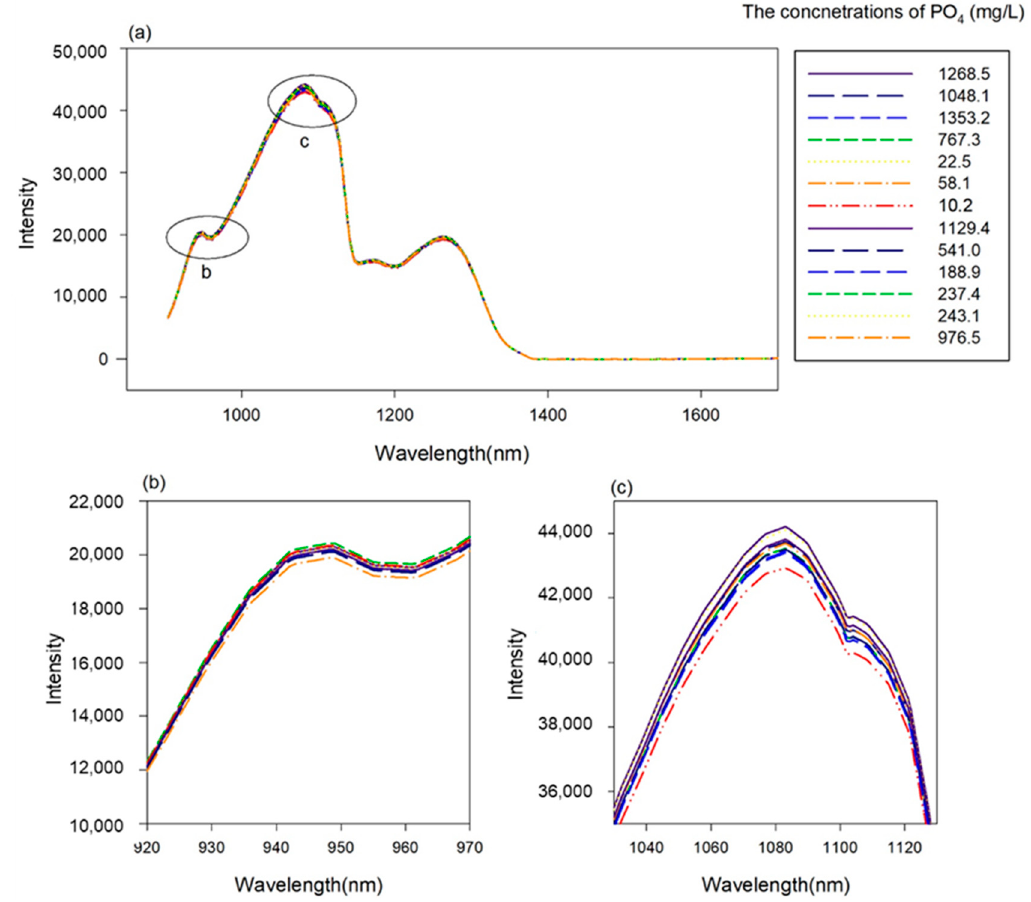
Figure 8. Intensity values of the NIR band for each PO 4- concentration. ( a ); PO 4 absorption wavelength band in 920 to 970 nm (b ); PO 4 absorption wavelength band in 1040 to 1140 nm ( c ).